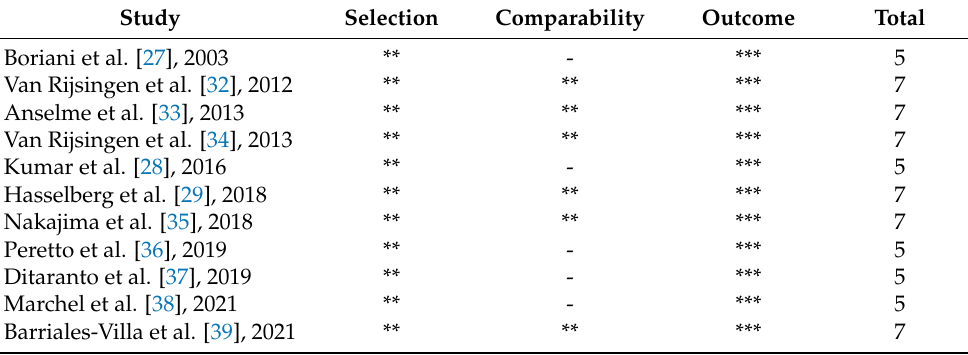
Table 2. Newcastle–Ottawa quality assessment for the cohort studies. “*” stands for 1 point in the specific